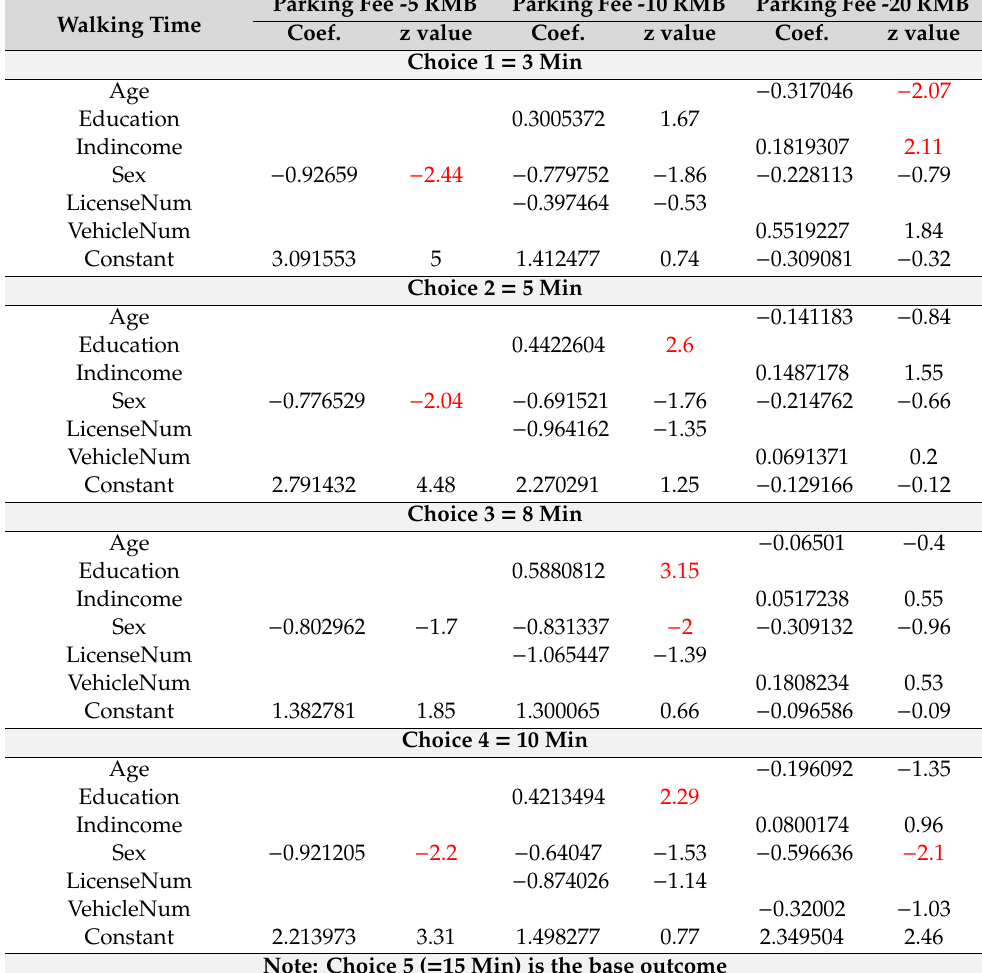
Table 2. Multinomial logit (MNL) models for the influence of parking fee on walking time. Parking Fee -5 RMB Parking Fee -10 RMB Parking Fee -20 RMB Walking Time Coef. z value Coef. z value Coef. z